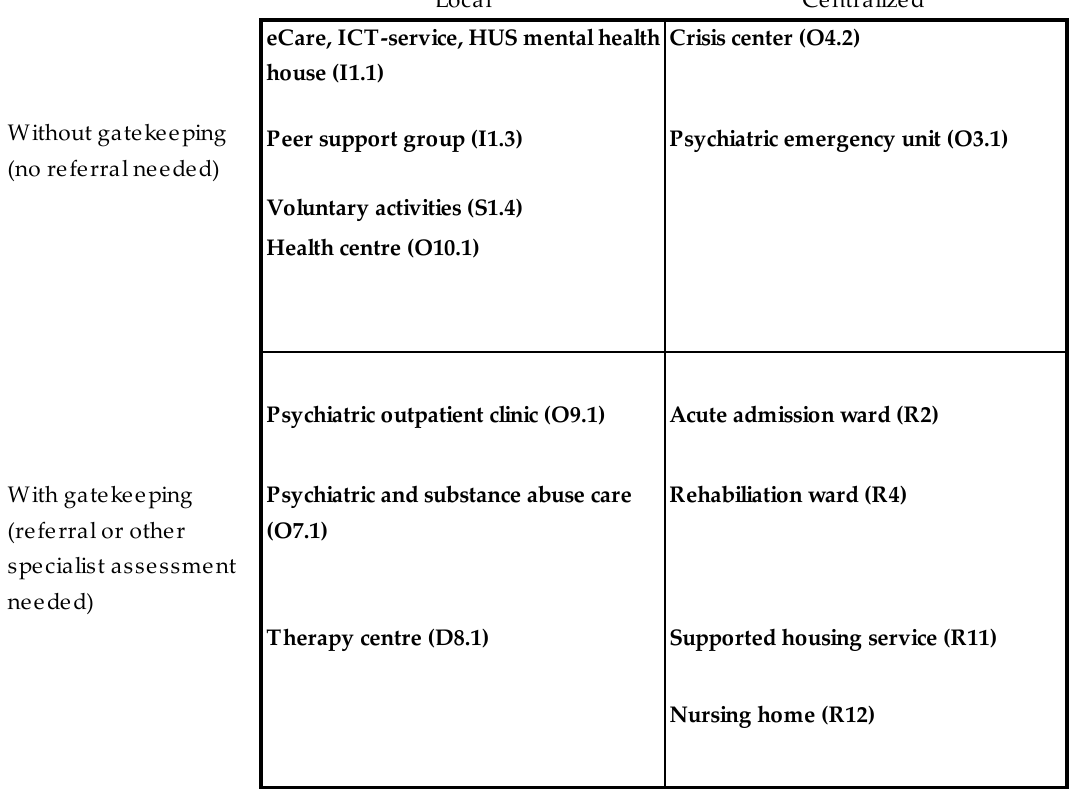
Figure 1. Quadrangle for ESMS-R* main types of care (MTC) new variable classification (Round One). *European Service Mapping Schedule–Revised.